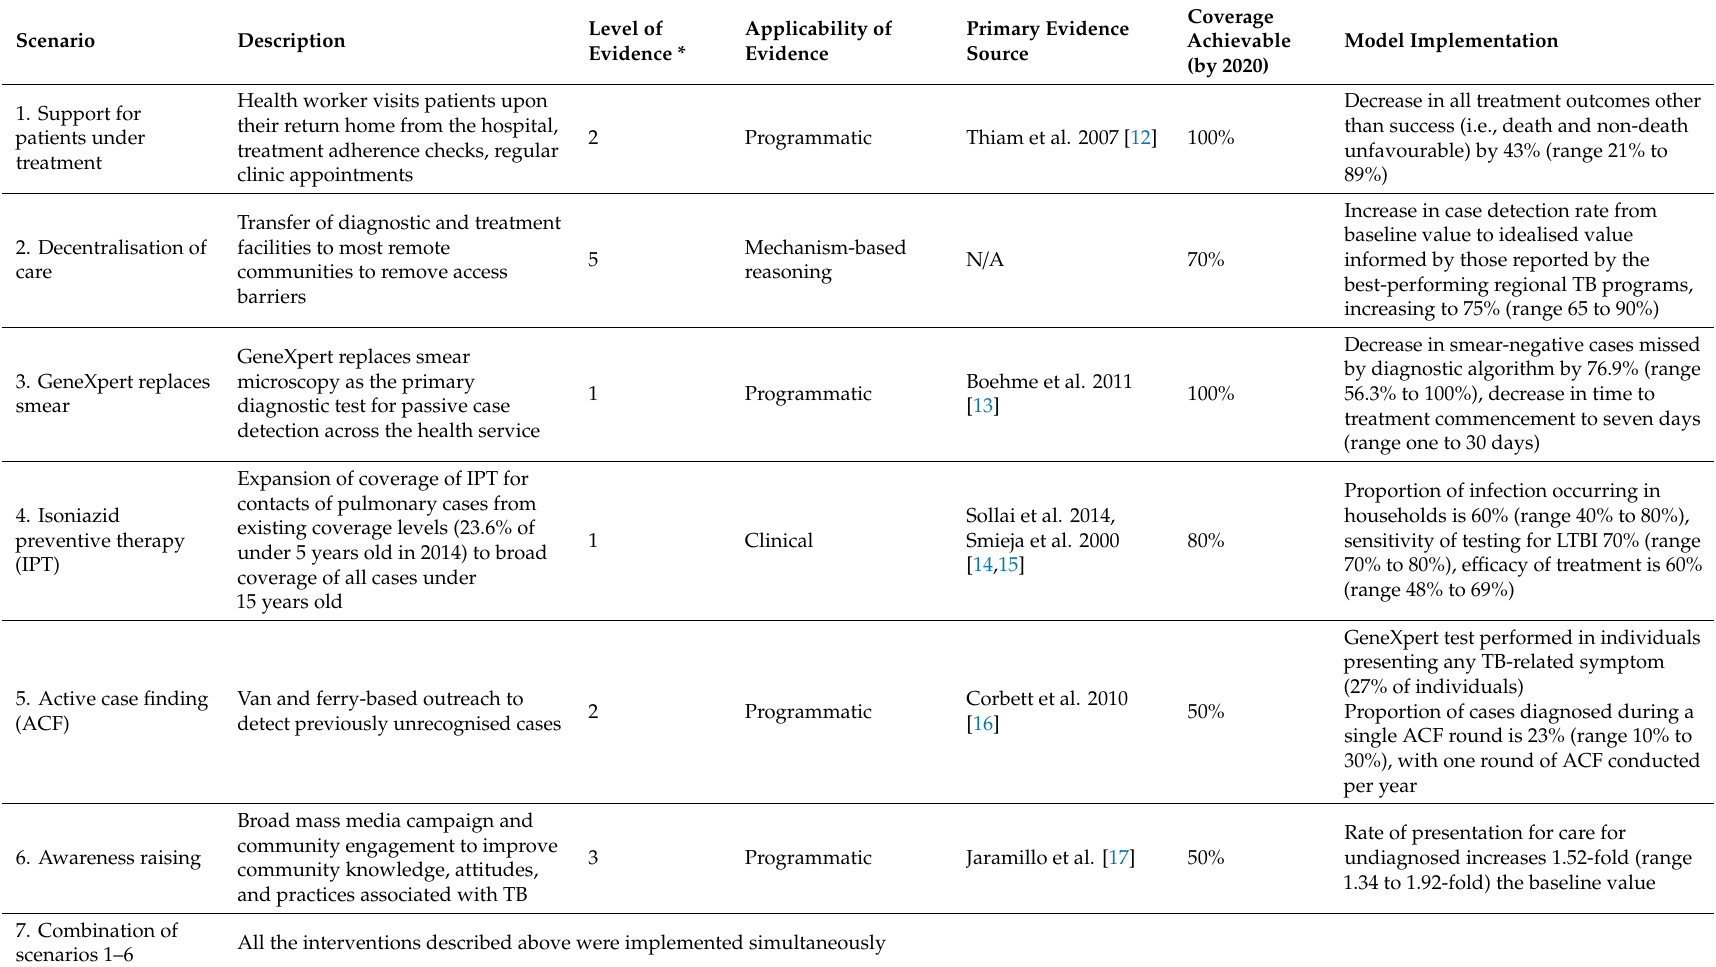
Table 1. Intervention